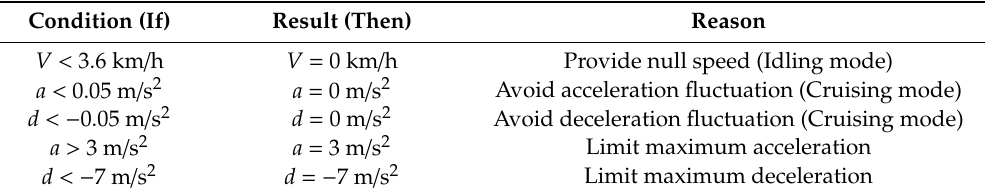
Table 1. Conditions in the filtering process.